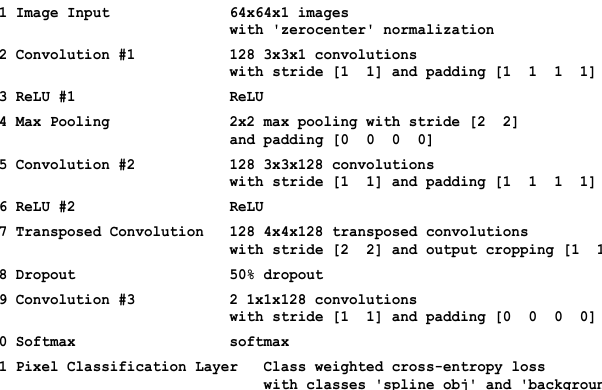
Fig. 4. The SSN architecture (in M ATLAB ) with two ConvLs and a single DeConvL. The DropOut layer following the DeConvL is optional.